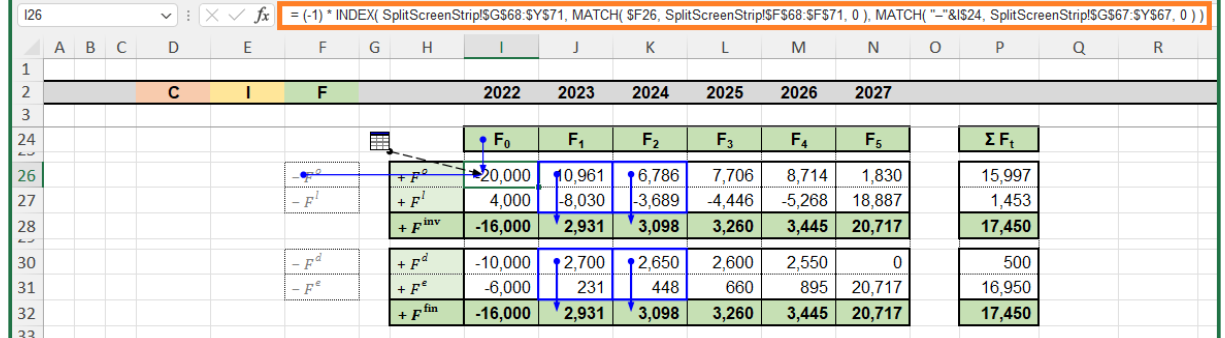
Figure 44. Cell I26 contains the formula for picking the operating cash flow 𝐹 (cid:3042) as of the period 𝑡 = 0; cells I28:N28 and I32:N32 contain the sums of the two rows above (“TransMatrix”